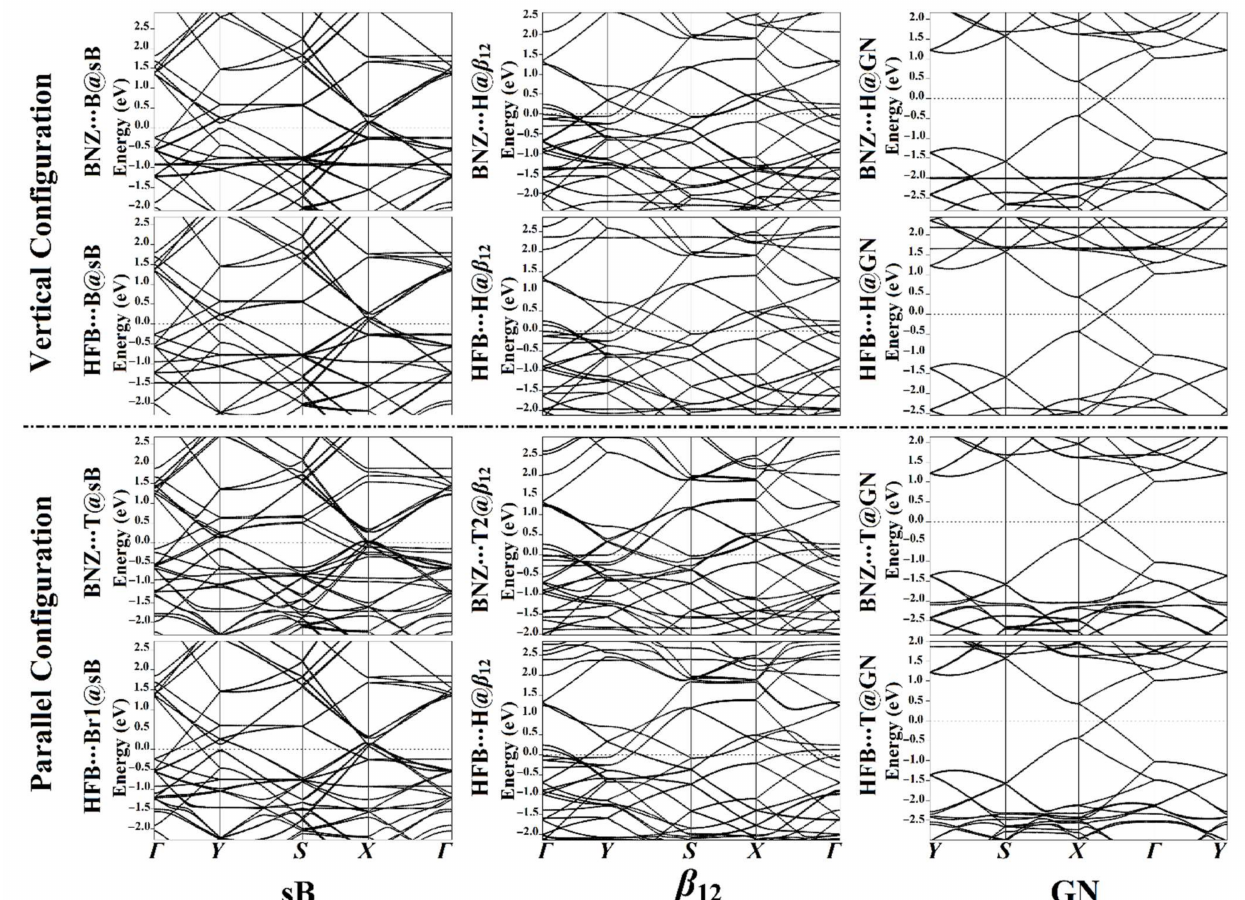
Figure 6. Band structure plots for the sB, β 12 , and GN after the adsorption process of BNZ and HFB at the most energetically favorable adsorption sites in the vertical and parallel configurations. The Fermi energy was set to